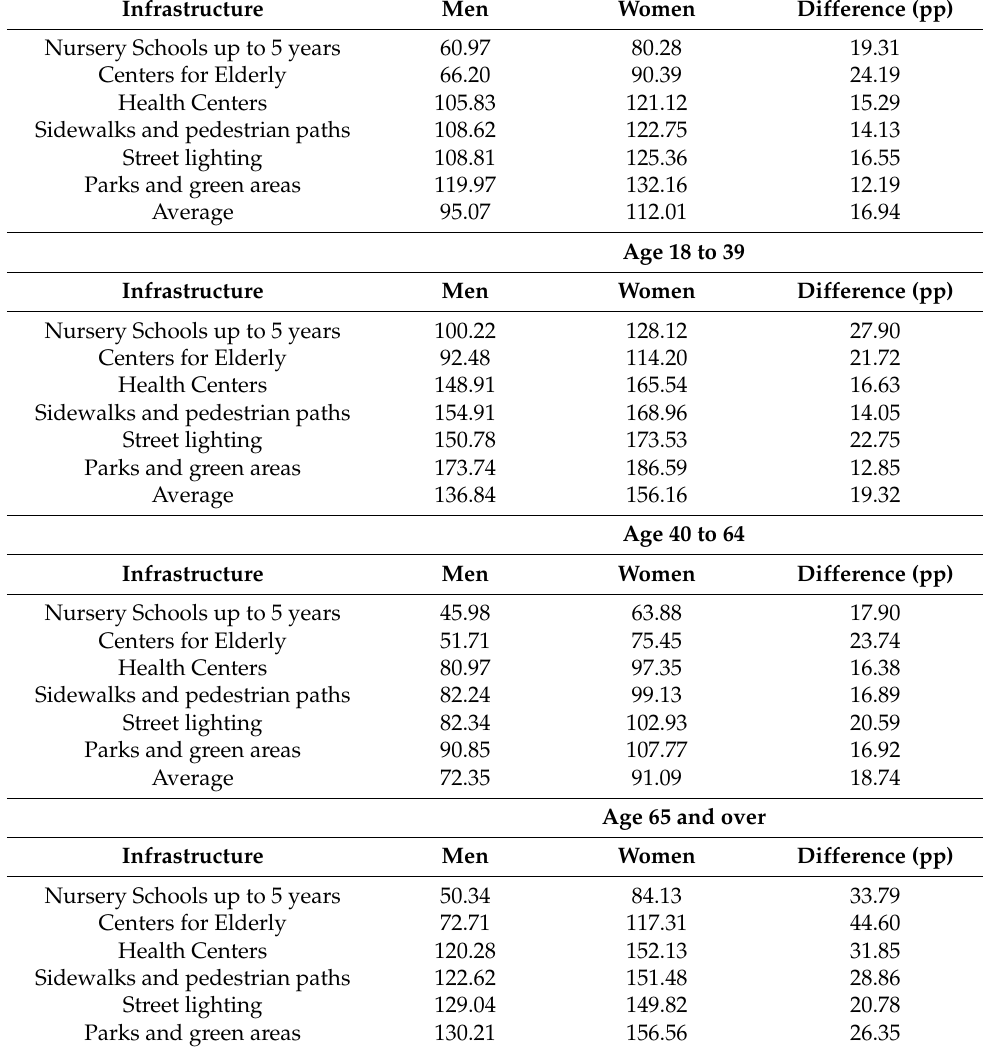
Table 5. Subjective Well-being Index for infrastructure from a gender perspective (mean =